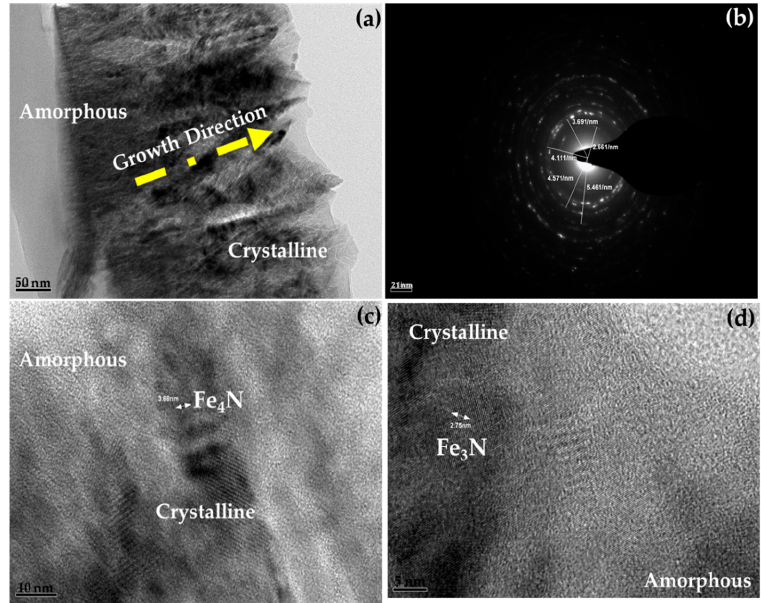
Figure 16. TEM micrographs of the FeN thin film deposited for 15 min on both sides at 10 sccm nitrogen flow rate ( a ) TEM image; ( b ) SAED pattern and ( c ), ( d ) HRTEM image.